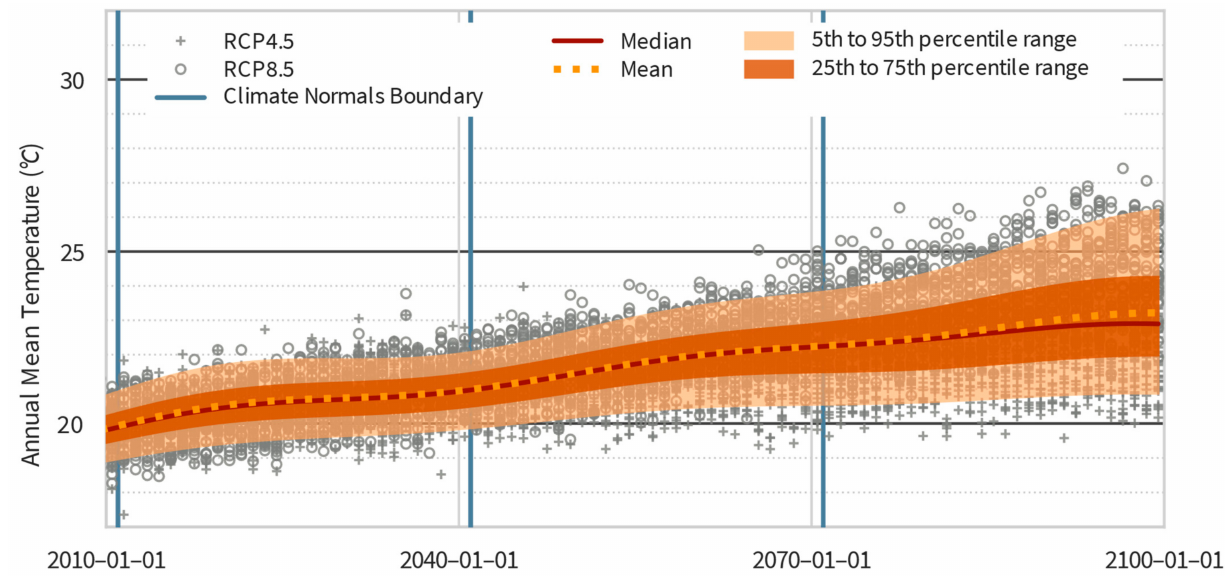
Figure 4. Localized Constructed Analogs (LOCA) downscaled ensemble global climate model (GCM) annual mean temperature results. An integrated cone of uncertainty for future temperature is overlain on weather results from two emissions scenarios, Representative Concentration Pathway (RCP) 4.5 and 8.5. Annual average temperature increases by approximately 3 ◦ C from 2011–2100.